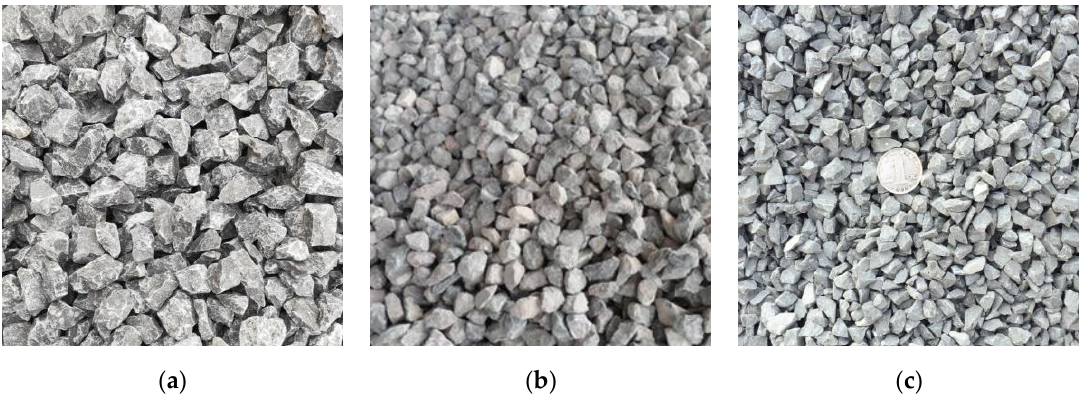
Figure 1. The coarse aggregate sample: ( a ) diabase, ( b ) granite, and ( c ) limestone. Table 4. Technical indexes of the coarse aggregates.